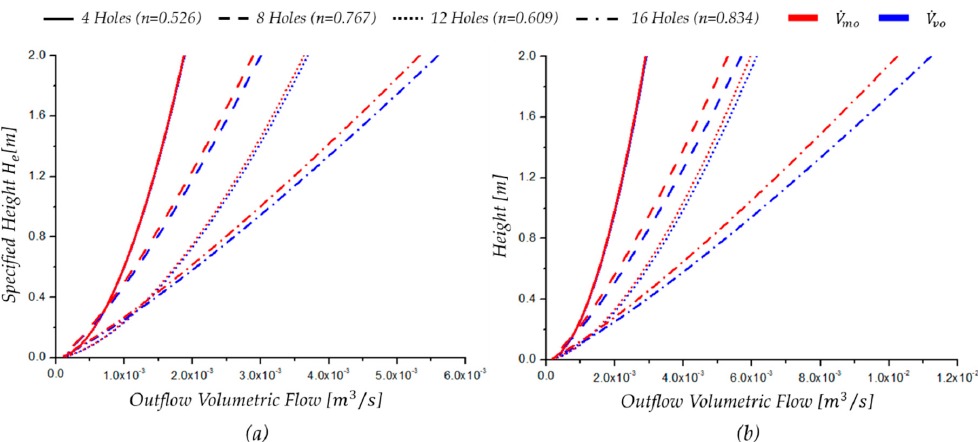
Figure 5. Outflow volumetric flow at different enclosure heights according to the number of leakage holes predicted by the existing and proposed theoretical equations: ( a ) IG-01 ; ( b ) HFC-125.